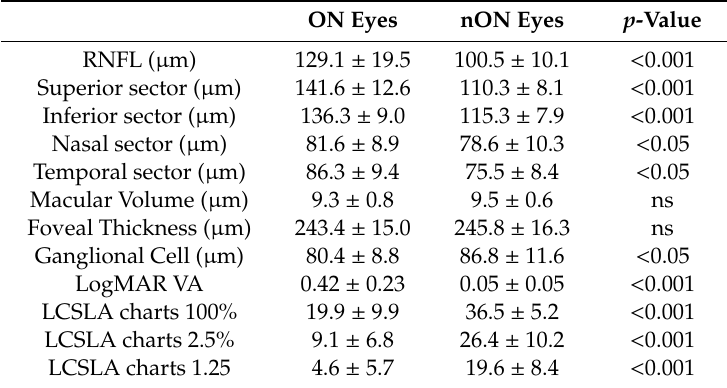
Table 2. Di ff erences in clinical and retinal data a between ON and nON eyes in the cohort of MS patients at baseline